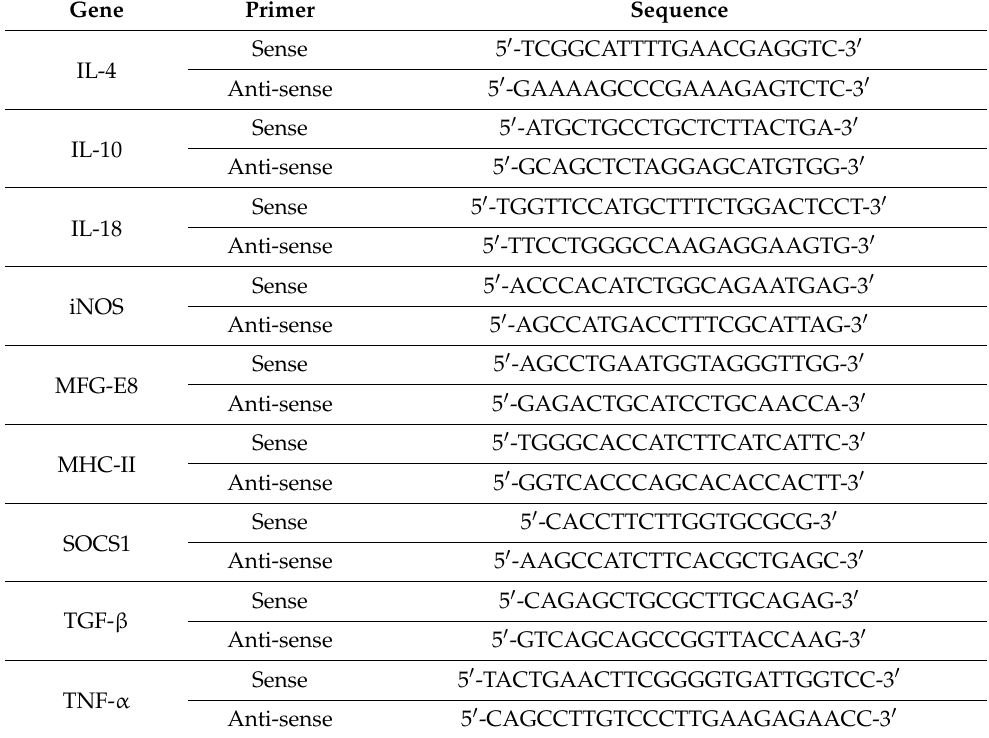
Table 1. Cont. Gene